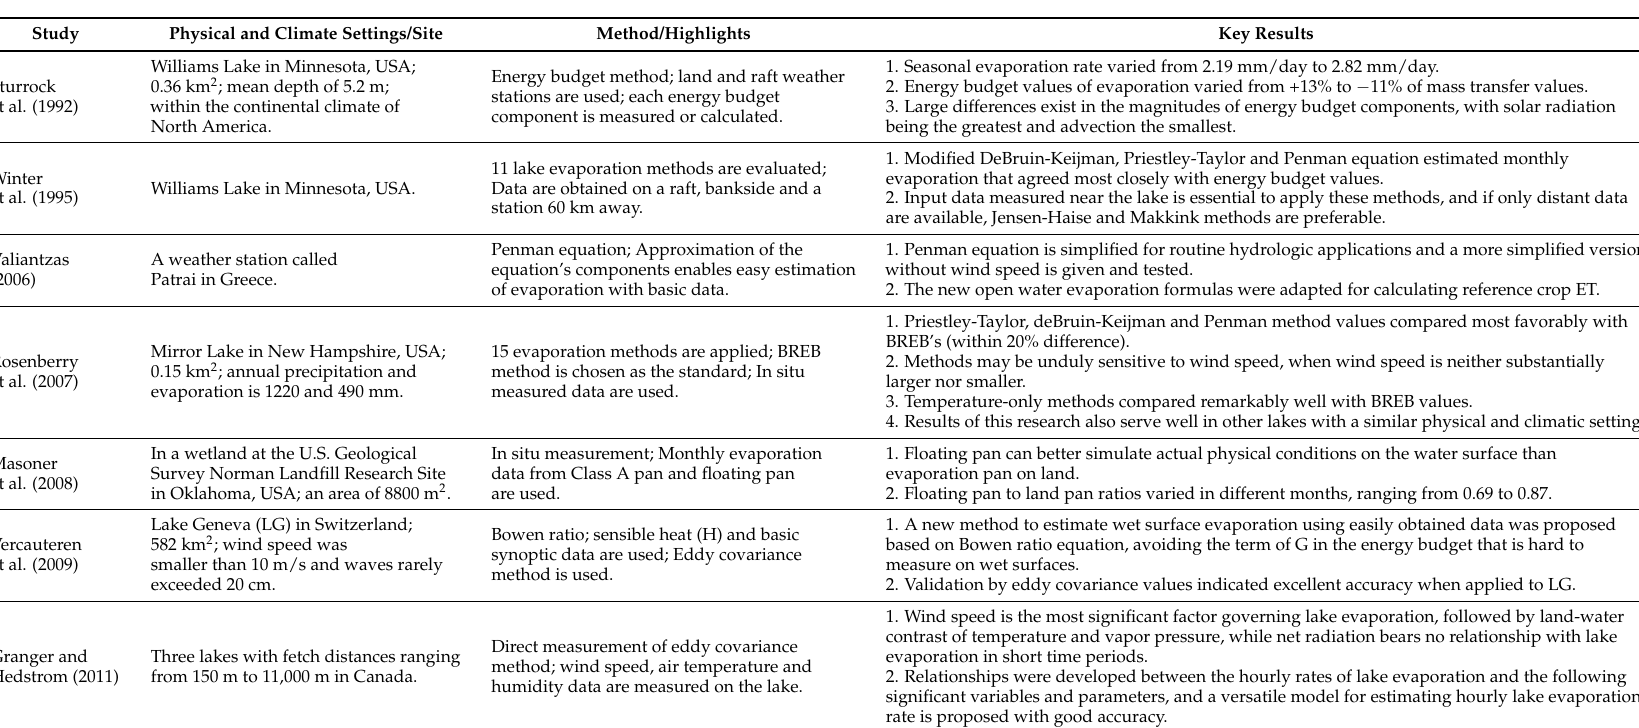
Table 1. Summary of relevant literature on open water evaporation studies based on in situ measurement or model estimation (the current paper is added for